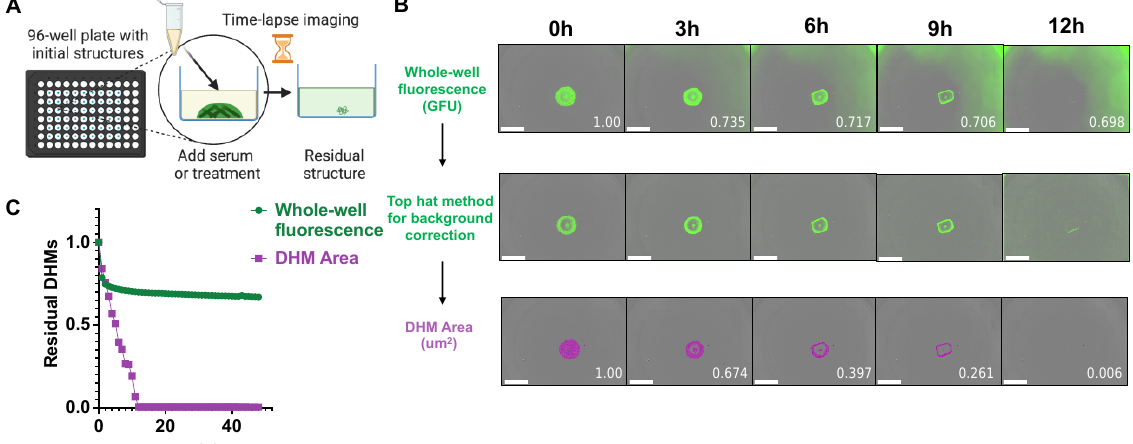
Figure 2. DHM degradation imaging procedure. ( A ) Each well of a 96-well microplate contained DHMs pre-stained with SYTOX Green and was imaged periodically by an in-incubator microscope. Schematic created with BioRender.com, created on 01 October 2022. ( B ) Time-lapse images of DHM degradation by 10 U/mL deoxyribonuclease I (DNase I) pre- and post-image processing. The col- lected green, fluorescent images can show signals from degraded DHM fragments in solution (top panel, normalized GFU values in white). Incucyte ® Software 2022A (Essen BioScience, Ann Arbor, MI, USA) image analysis was applied to segment the object area in each image (magenta traces, bottom panel, normalized area values in white). The scale bar is 800 μm . ( C ) Plots of DHM degra- dation by 10 U/mL DNase. The green fluorescence (green) and image-processed DHM area (ma- genta) are compared in the plot. 2.3. DNase I Degrades DHMs in a Dose-Dependent Manner We analyzed DHM degradation using a three-fold dilution series of DNase I and image processing as described above (Figure 3A). Total DNase digestion was observed with the highest DNase I concentration of 10 U/mL by 12 h. Lower DNase I concentrations did not completely degrade the DHMs within the 48 h analysis period. Nuclease buffer in the absence of DNase I served as a negative control condition. The residual DHM area was calculated using the final DHM area as a percentage of each structure ’ s corresponding initial baseline DHM area with the equation below: % 𝑅𝑒𝑠𝑖𝑑𝑢𝑎𝑙 = 𝐹𝑖𝑛𝑎𝑙 𝐴𝑟𝑒𝑎 𝐼𝑛𝑖𝑡𝑖𝑎𝑙 𝐴𝑟𝑒𝑎 ∗ 100%. (1) The mean for each treatment is plotted as %Residual in Figure 3B. The total extent of DHM degradation increased in a dose-dependent fashion when digested with DNase I. The residual DHM structures after nuclease digestion in plots (A) and (B) are visualized in Figure 3C. The fluorescent, green channel images revealed the partial digestion of low nuclease concentrations with small amounts of edge delamination and the center dim- ming with increasing DNase I concentration. Residual structures were very faint under 3.33 U/mL DNase conditions and degraded fully after 10 U/mL DNase incubation.